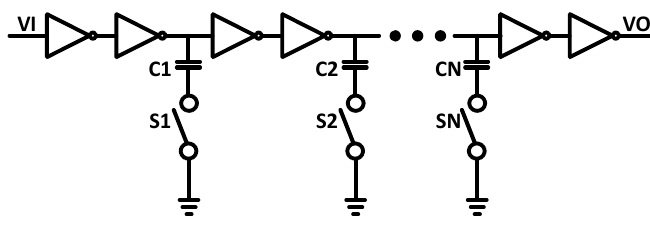
Figure 9. Schematic of variable delay cell.